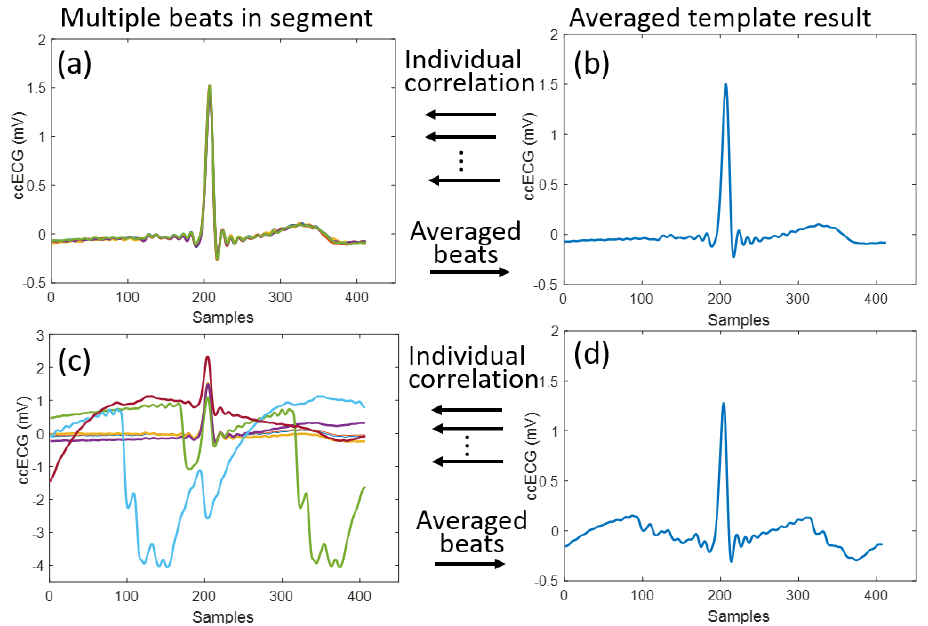
Figure 3. Example of template extraction for obtaining the morphology-based quality indicator denominated as corrSQI. In ( a ) a set of extracted beats from a clean ccECG segment is shown; these beats are then averaged to obtain the template shown in ( b ), and corrSQI is obtained by correlating this template to each individual beat in ( a ), leading to a high-quality metric. Likewise, ( c , d ) show the same procedure for a segment containing motion artefacts. Despite the artefacts, the template in ( d ) still has an ECG-like waveform, and can be used for the individual correlation with the beats in ( c ), resulting in a lower corrSQI than the one obtained from ( a ).